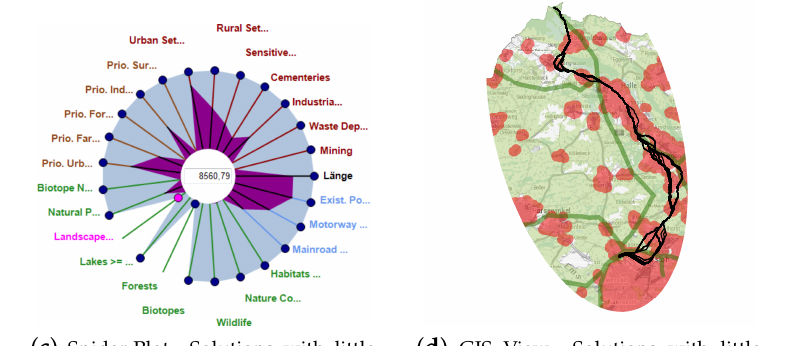
( c ) Spider-Plot: Solutions with little ( d ) GIS View: Solutions with little impact on landscape conservation areas impact on landscape conservation areas Figure 4. Interactive Visualisation System: ( a , c ): spider-plot as a graphical control element to support navigation through the set of Pareto-optimal solutions. Criteria are classified into groups (visualised by different colours of sliders and labels). The blue polygon outlines the current slider positions and thus restrictions in the accompanying solution space dimension. The magenta coloured inner polygon shows the minimum possible values for each criterion induced by the current constraints. In the centred circular area of the widget, the current length restriction of the highlighted criterion is shown (in map units, here metre). ( b , d ): resulting paths for different solution space restrictions are visualised in